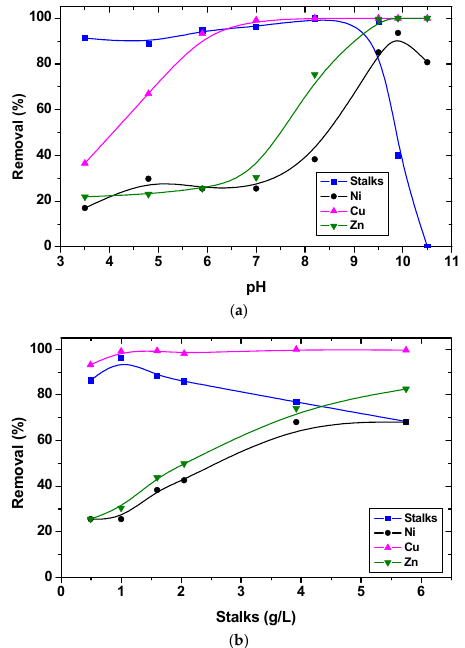
Figure 3. Use of grape stalks as a biosorbent: ( a ) Influence of solution pH on (modified) biomass in the presence of surfactant; and ( b ) influence of biomass concentration. Reprinted with permission; copyright Wiley [47].